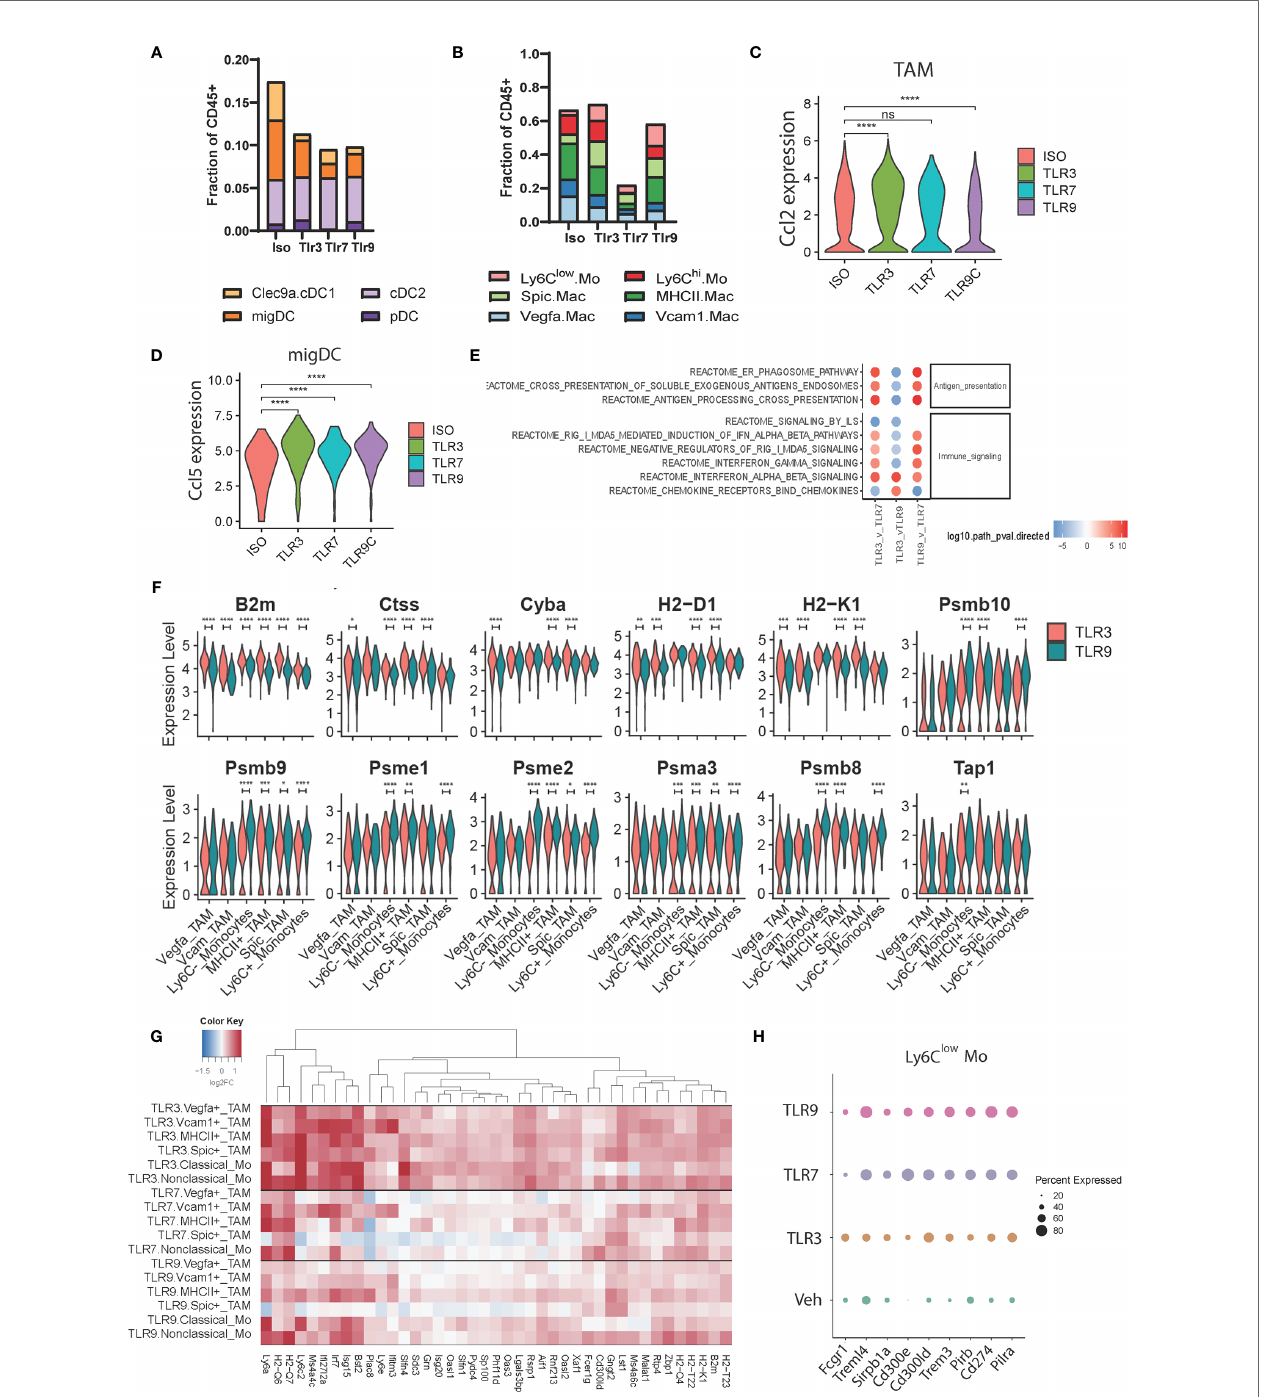
FIGURE 3 | Functional pro fi ling of TAM populations during TLR treatment. (A, B) The frequency of tumor-associated (A) dendritic cell and (B) macrophage subsets amongst CD45 + cells 24 hours post injection of TLR agonist, (C, D) Violin plots showing the expression distribution of (C) Ccl2 mRNA between treatments for all TAM subsets, and (D) Ccl5 mRNA within the activated migDC subset. (E) fGSEA pathway enrichment of Reactome pathways of TAM-associated genes compared to vehicle control, (F) Violin plots showing expression distribution of antigen-presentation associated genes in TAM subsets for TLR3-treated (red) and TLR9-treated (blue) tumors, (G) Hierarchical clustering of differentially expressed genes upregulated upon TLR3-treatment (clusters 5 and 11 from Figure S1E ) showing uniform induction of gene expression in non-TLR3 expressing TAM subsets, and (H) Dotplot showing the relative expression of differentially expressed IgG and TNF receptor family members in nonclassical monocytes upon TLR agonist treatment. Statistical p values for panels (C, D, F) derived from Wilcoxon test; n.s., not shown, *p <= 0.05, **p <= 0.01, ***p <= 0.001, ****p <=